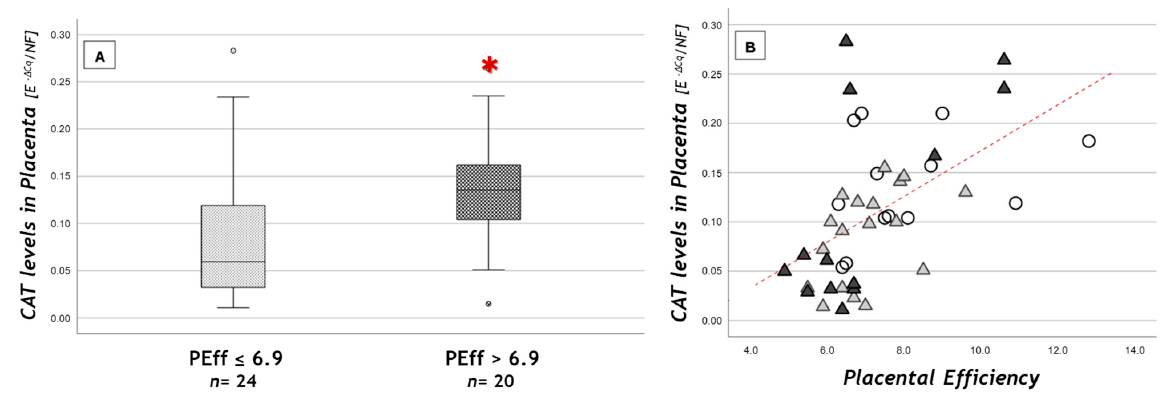
Table 5. Expression levels of macroautophagy and chaperone-mediated autophagy (CMA) genes in placental tissue.